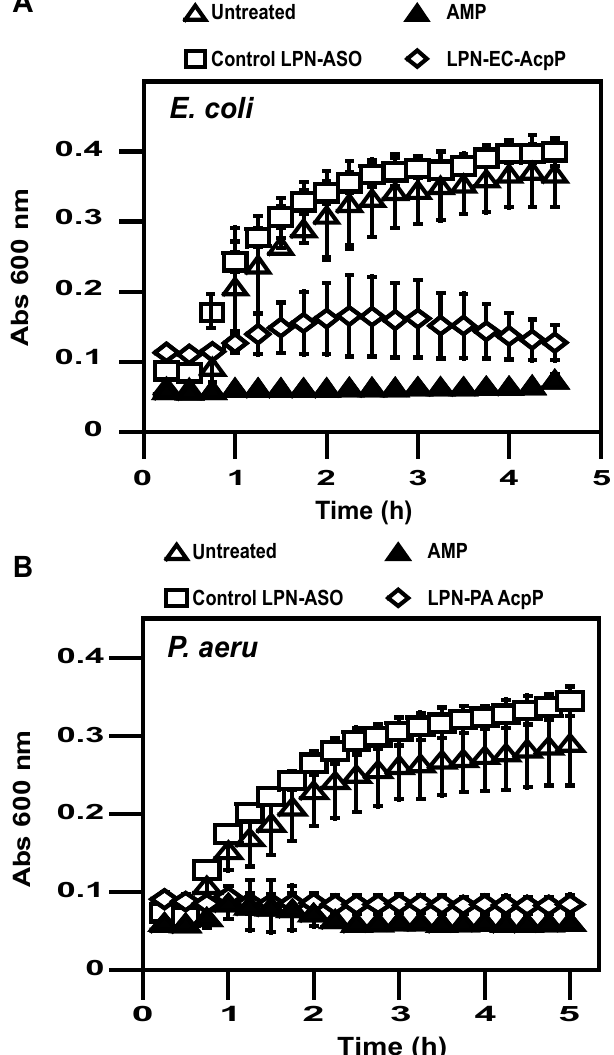
Figure 4. Antibacterial activity of LPN. The growth of E. coli ( a ) and P. aeruginosa ( b ) after treatment with LPN–ASO complexes (1 µM ASO) or ampicillin (AMP, 150 µg/mL) was monitored for 5 h at 37 ° C.